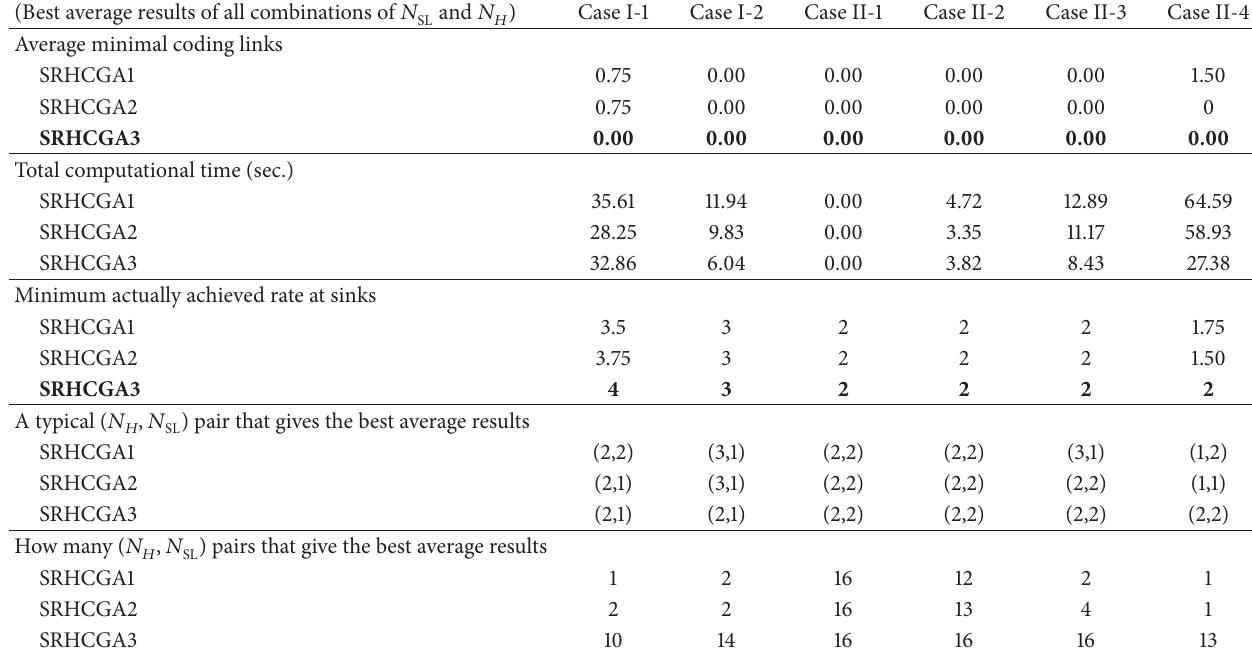
Table 6: Summarized results of general tests on SRHCGAs. and 𝑁 𝐻 ) Case I-1 Case I-2 SL